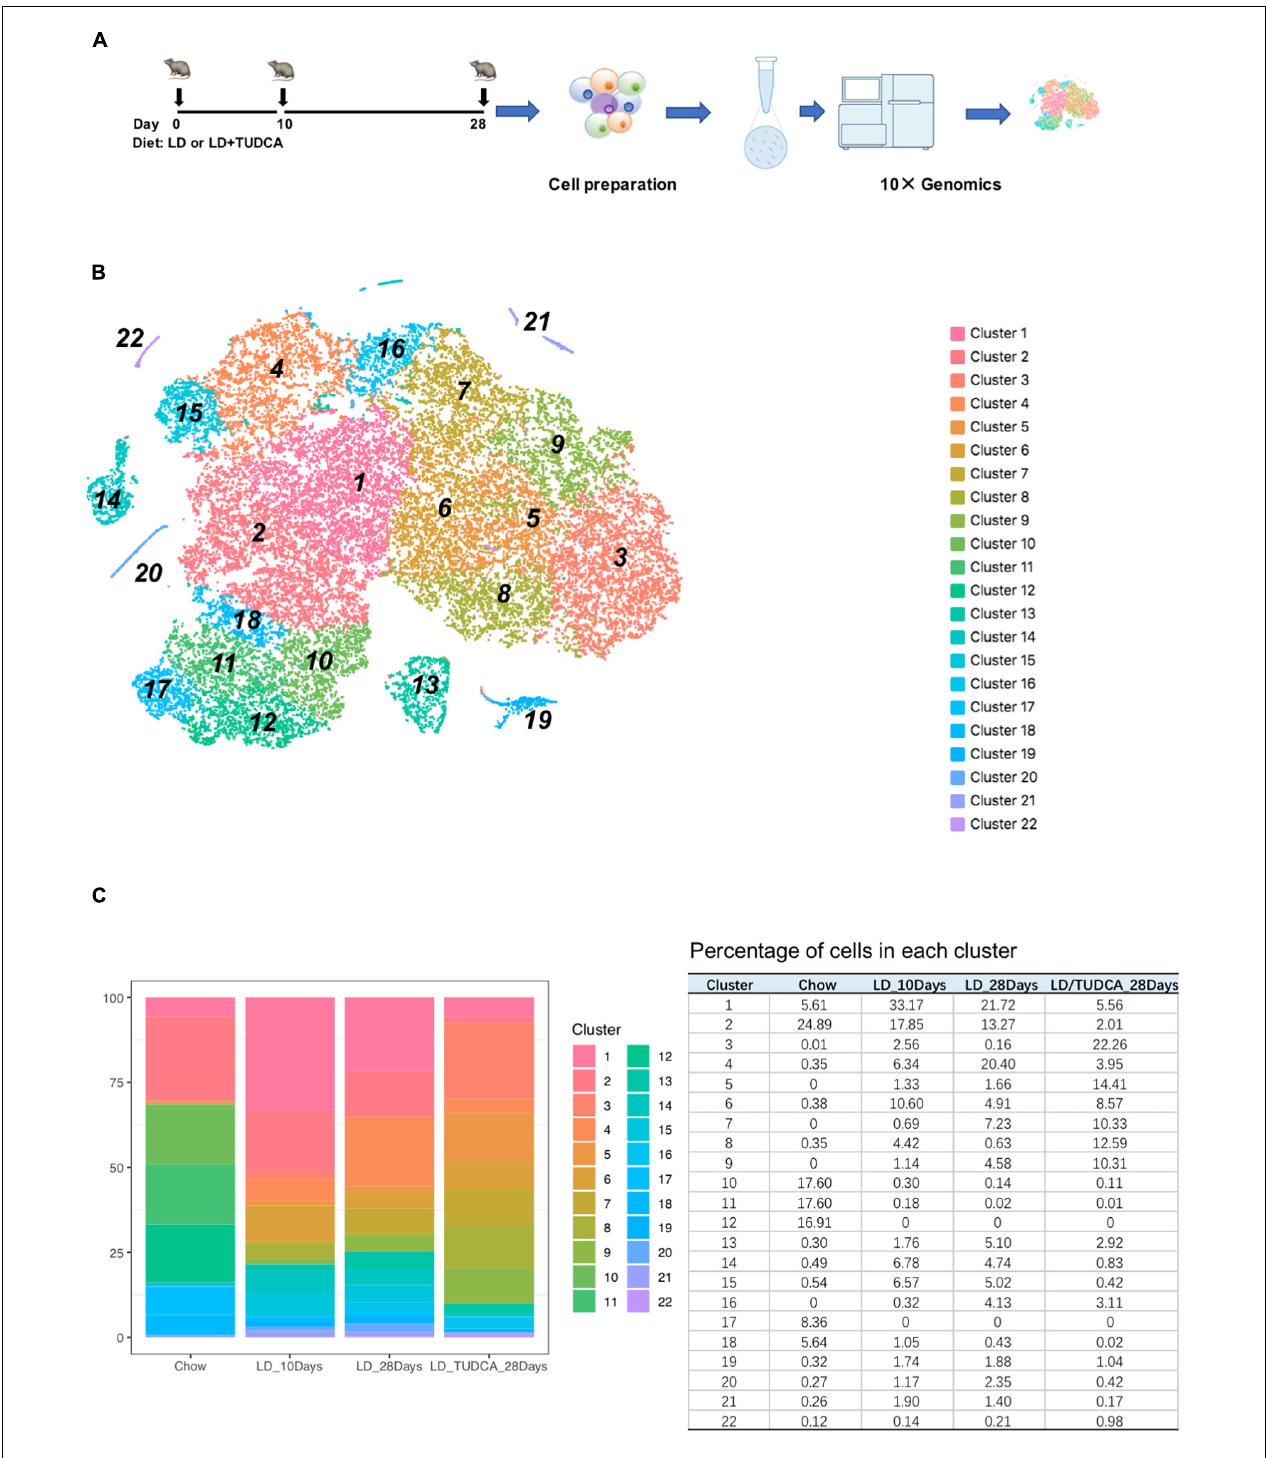
FIGURE 1 | The transcriptomic heterogeneity of murine gallbladder. (A) The experimental design of mouse exposure to lithogenic diet (LD) or LD+ tauroursodeoxychlic acid (TUD). Mice were sacrificed at day 0 (chow diet, basal condition), day 10, and day 28 of LD and day 28 of LD + TUD, respectively ( n = 15 mice/time point). At each time point, gallbladders were harvested and cell suspension were prepared and processed for 10 × genomic single cell sequencing (scRNA) under the standard protocols. (B) tSNE plot identified 22 clusters of gallbladder cells from scRNA sequencing data. (C) Stacked bar graph (left) and table (right) showing proportions of gallbladder cells in each cluster at each time point during process of cholesterol gallstone formation.